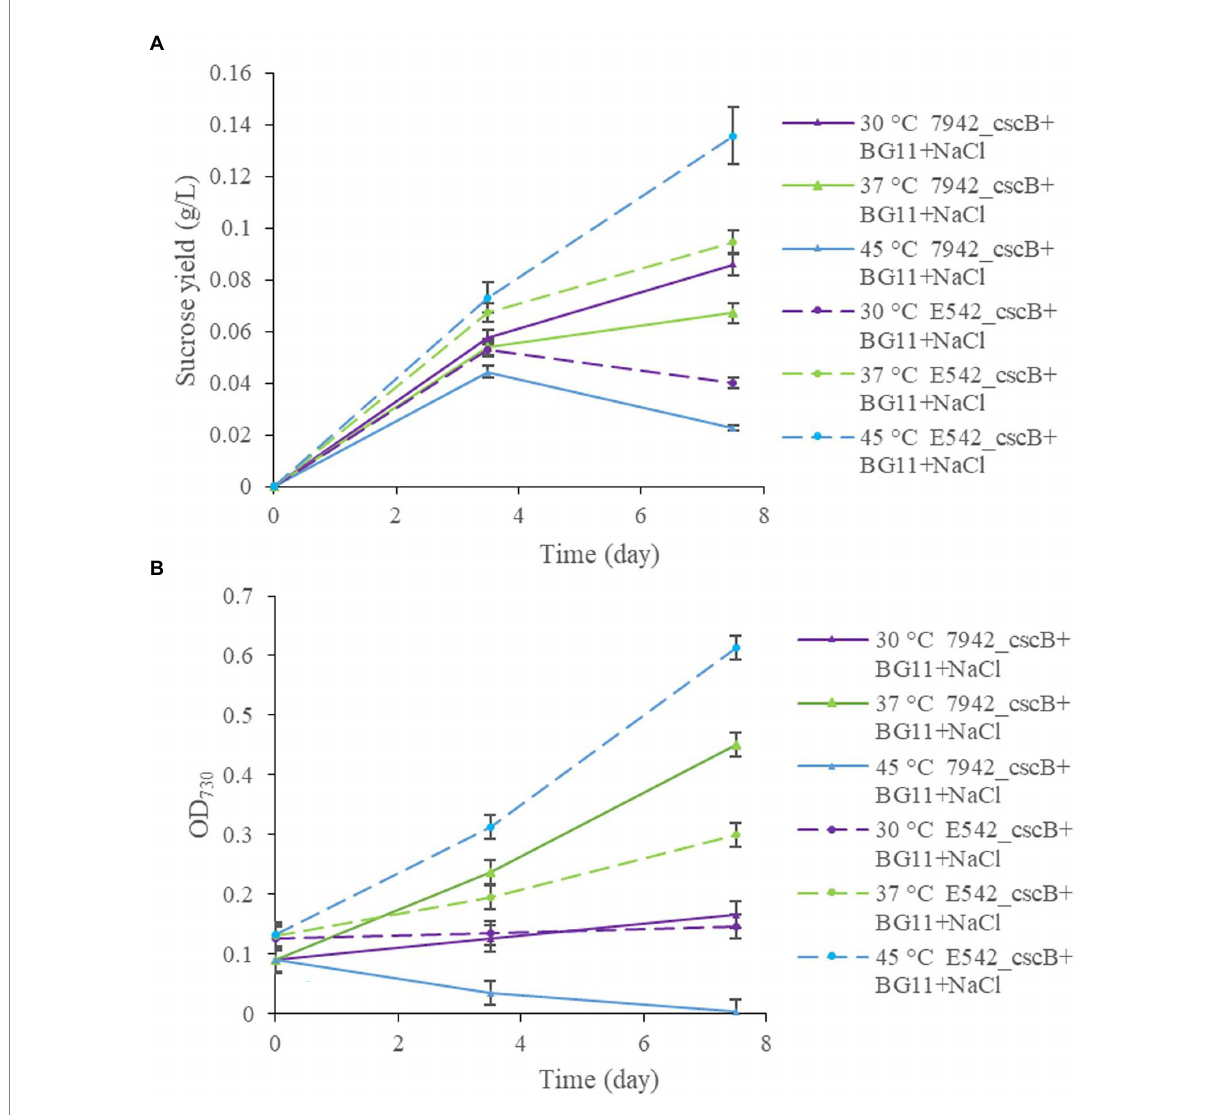
FIGURE 3 The comparison of sucrose yield (A) , and growth curve (B) , of engineered E542 _cscB + and 7,942 _cscB + strains at different temperatures grown in BG-11 medium under salt stress. Distribution of the data points shows the mean of three independent experiments with error bars representing SD from